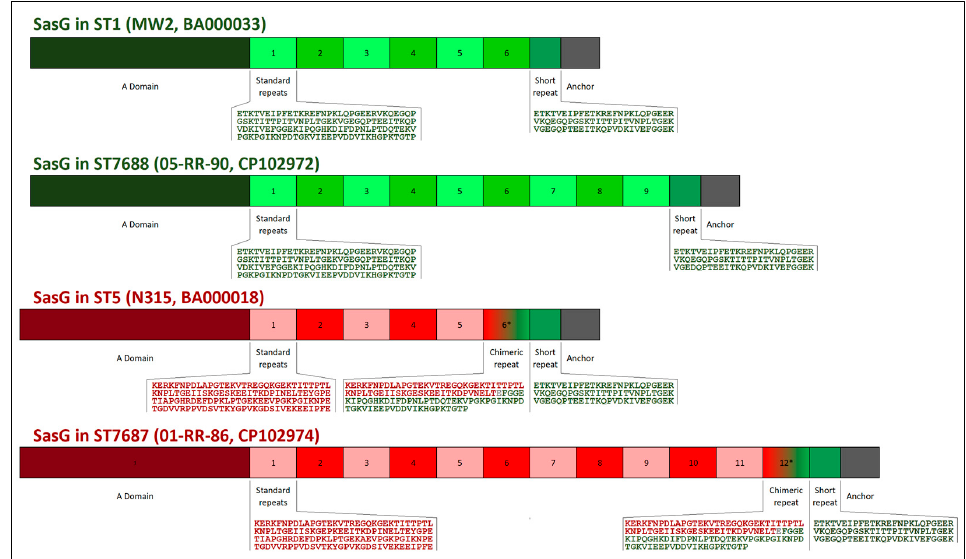
Figure 2. Diagram of S. aureus surface protein G comparing the two different alleles and different repeat numbers.